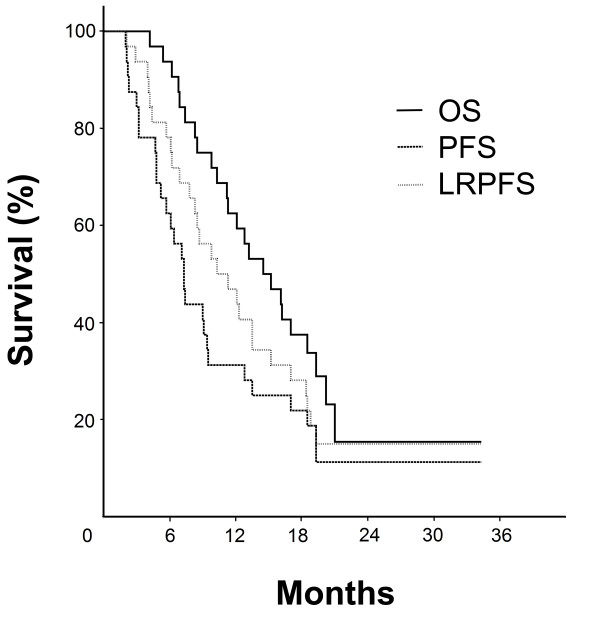
Survival curves for study population. Solid line: OS; Dashed line: PFS; Doted line: LRPFS.